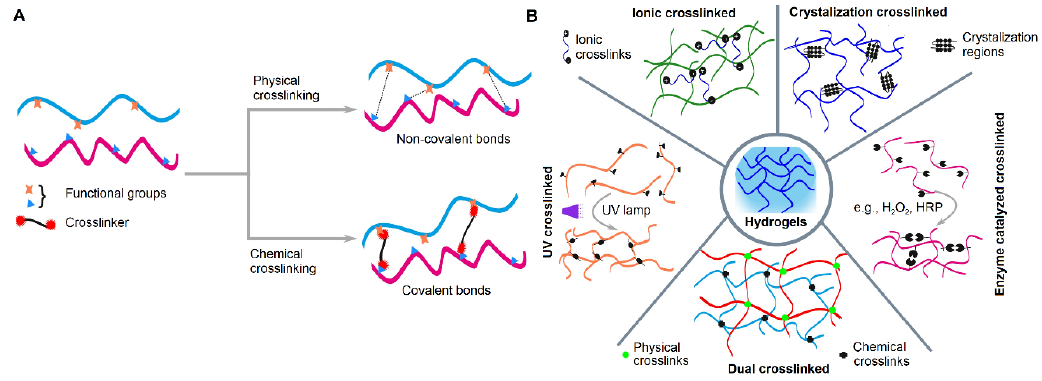
Figure 2. Representation showing ( A ) the effect of physical and chemical crosslinking on the type of bonds formed and ( B ) several examples of different crosslinking techniques.